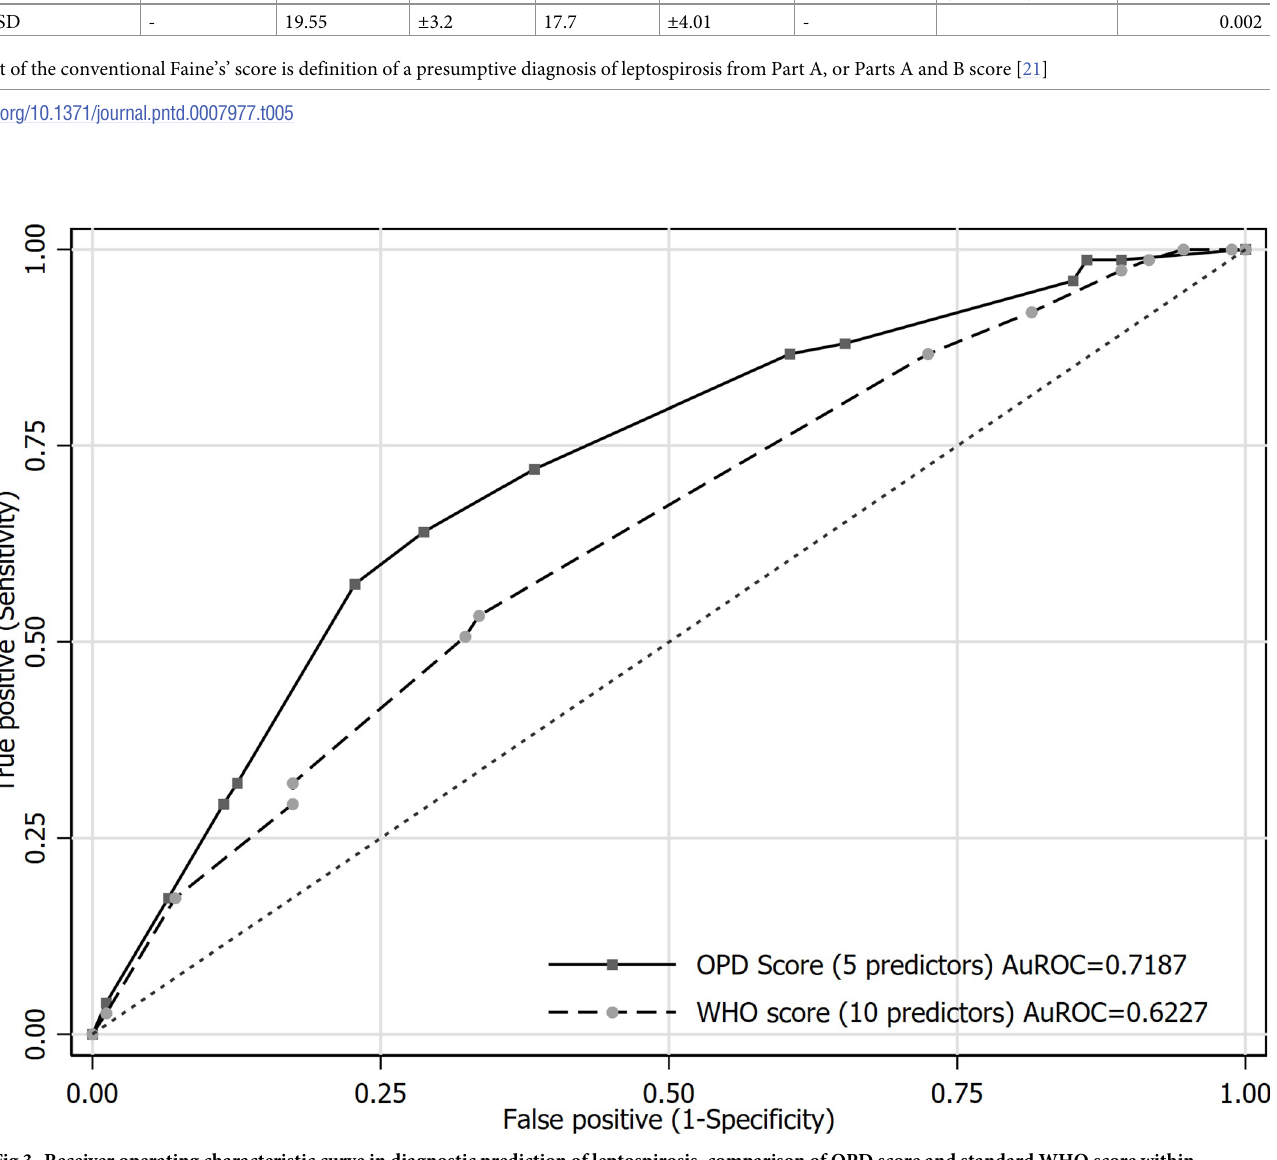
PLOS NeglectedTropical Diseases | https://doi.org/10.1371/journal.pntd.0007977 January 9,